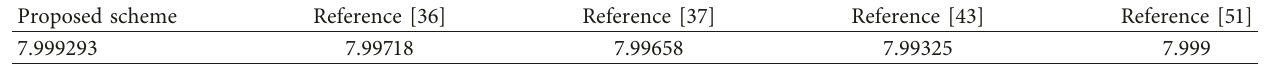
Table 7: Average entropy analysis for the proposed method and other reference methods.